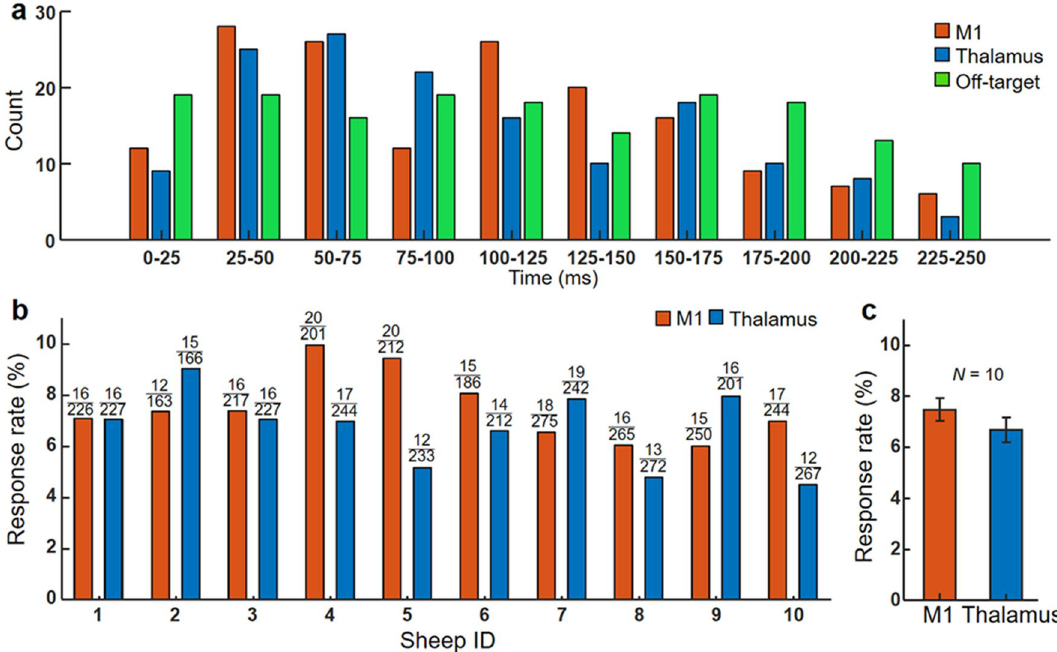
Figure 5. Latency distribution and response rate of EMG elicited by excitatory FUS sonication. ( a ) A histogram of onset latencies of selected EMG signals after the FUS onset across all animals. The signals were obtained from the hind limb contralateral to sonication. ( b ) Response rates in excitatory sonication to the M1 (red bars) and thalamus (blue bars) from each animal and ( c ) their average across all sheep ( N = 10). The error bars indicate standard errors. The numbers above each data bar represent response counts (numerator) and the total number of trials